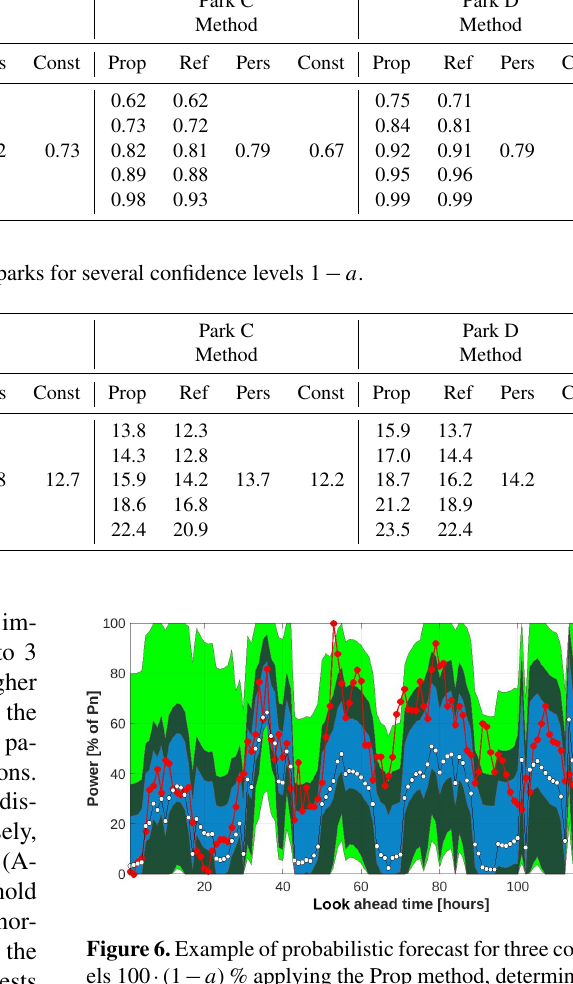
Table 1. Reliability results for the applied methods in the different parks for several confidence levels 1 − a . Park A